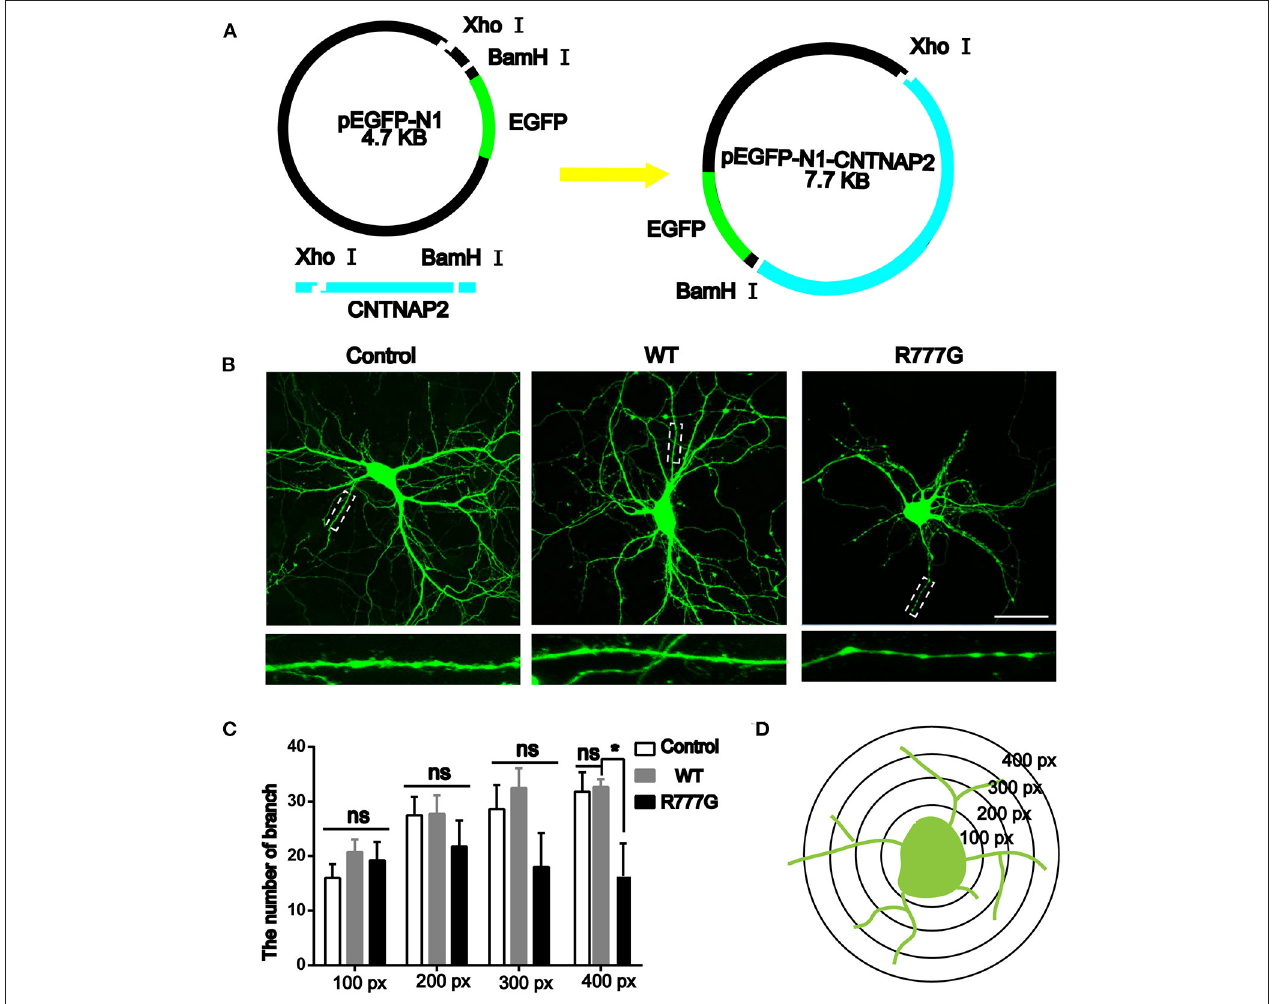
FIGURE 2 | Effects of CNTNAP2 R777G on the morphological change of primary cultured neurons. (A) Schematic diagram of the pEGFP-N1-CNTNAP2 plasmid, which can express GFP and Caspr2 simultaneously. (B) Representative fluorescent images of primary cultured neurons transfected with vehicle, wild type or CNTNAP2 R777G plasmid, respectively. The enlarged images below are magnified views of the dotted square regions. (C) The number of neurites intersections in each circle was counted to obtain a statistical diagram of the number of dendrites of primary cultured neurons in different groups, with the radius of 100, 200, 300, and 400 px, respectively. (D) Schematic diagram of neurites intersections. Scale bar: 100 µ m. ANOVA and Bonferroni’s post-hoc test, * p < 0.05, ns, not